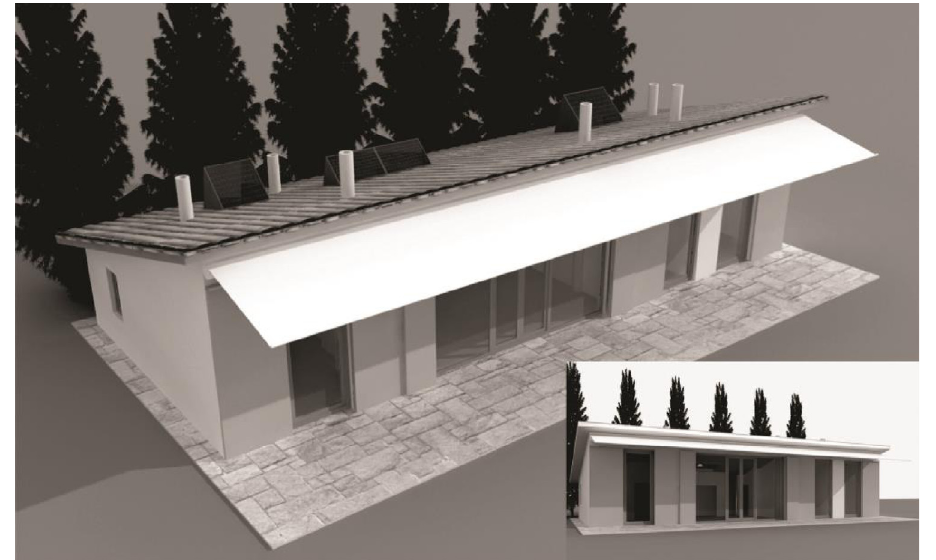
Fig. 6. Perspectives of House